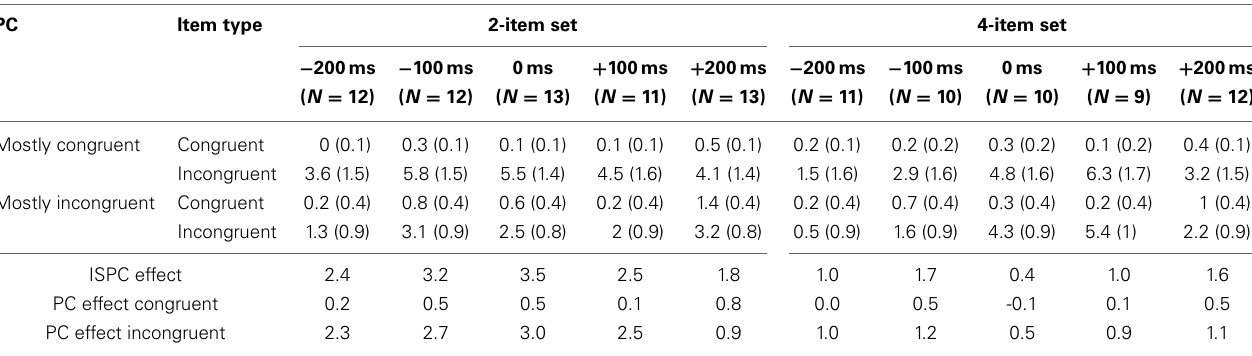
Table 6 | Percentage of errors for the conditions of Experiment 2.